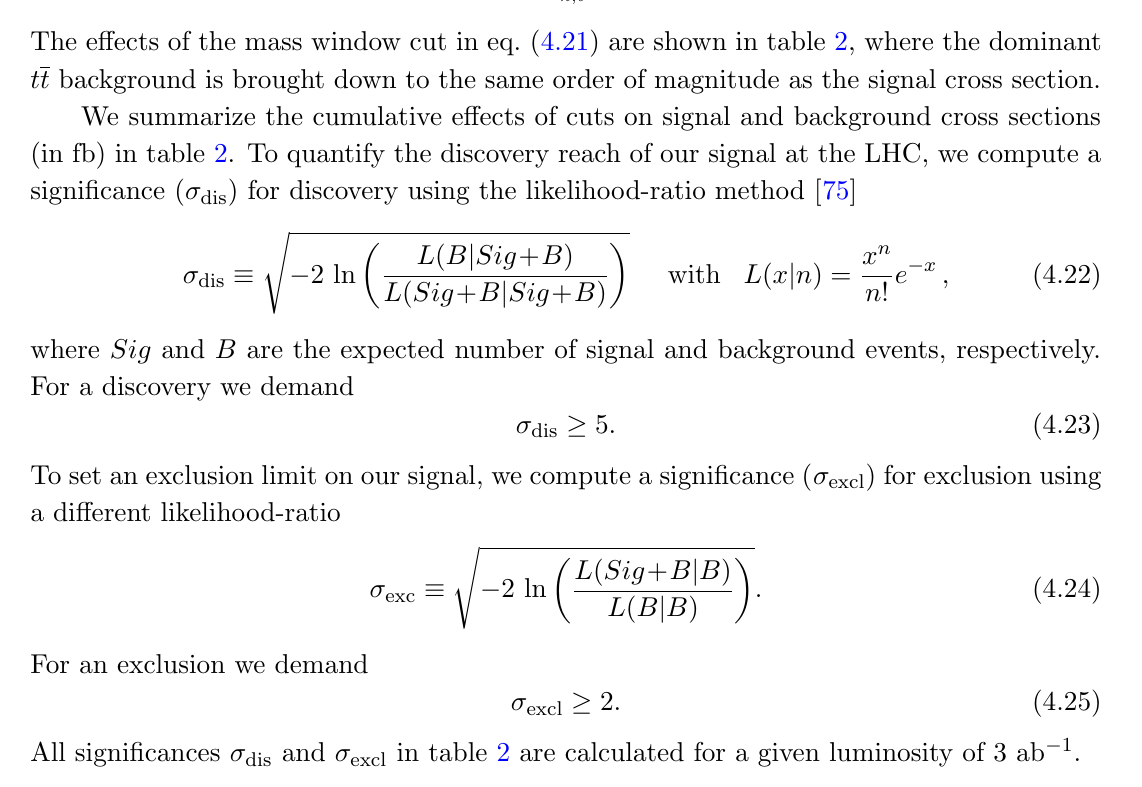
Figure 5 . The distributions of reconstructed top partner invariant masses m reco (right) in the ttgg channel for m T = 1 : 0